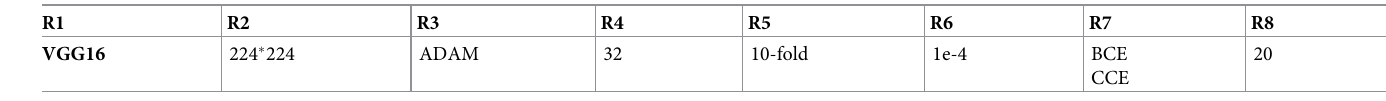
R1—Model, R2—Image Size, R3—Optimizers, R4—Mini Batch Size, R5—cross validation, R6—Initial Learning Rate, R7—Loss function, R8—Epoch, BCE—Binary cross-entropy, CCE—Categorical cross-entropy.